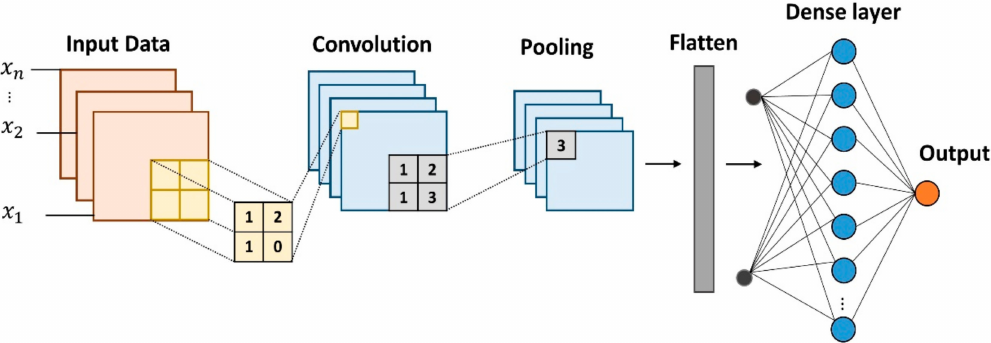
Figure 2. CNN deep learning